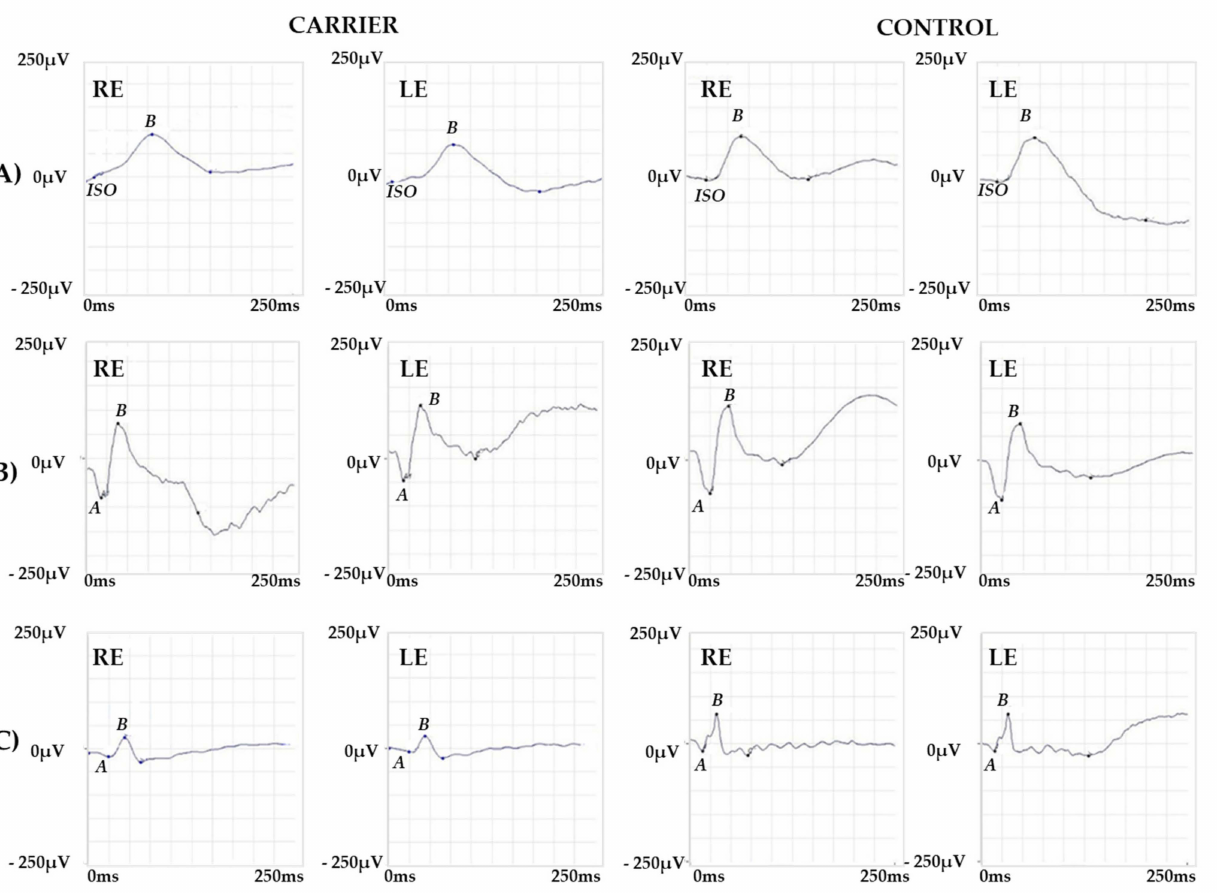
Figure 5. ERG Responses. ERG recordings showing ( A ) a normal scotopic and ( B ) combined response and ( C ) a reduced photopic response. Representative examples of ERG responses from a normal subject are shown for comparison. Legend: RE, right eye; LE, left eye; ISO, isoelectric line; A, a-wave; B